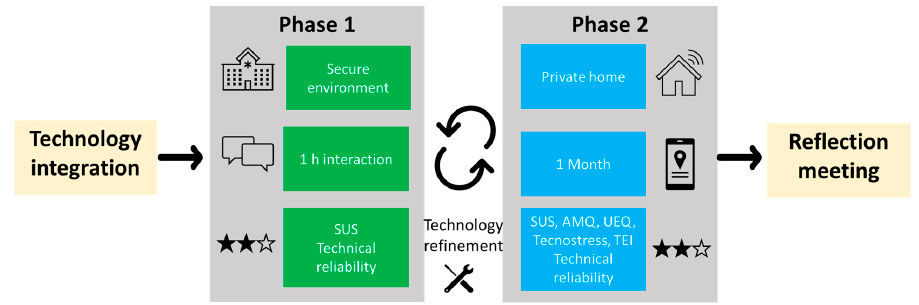
Figure 6. Highlights of the pre-validation phases: the different experimental settings, the duration of the interaction, and the evaluation framework. Phase 1 aimed to evaluate the stand-alone technology, whereas the Phase 2 aimed to evaluate the integrated